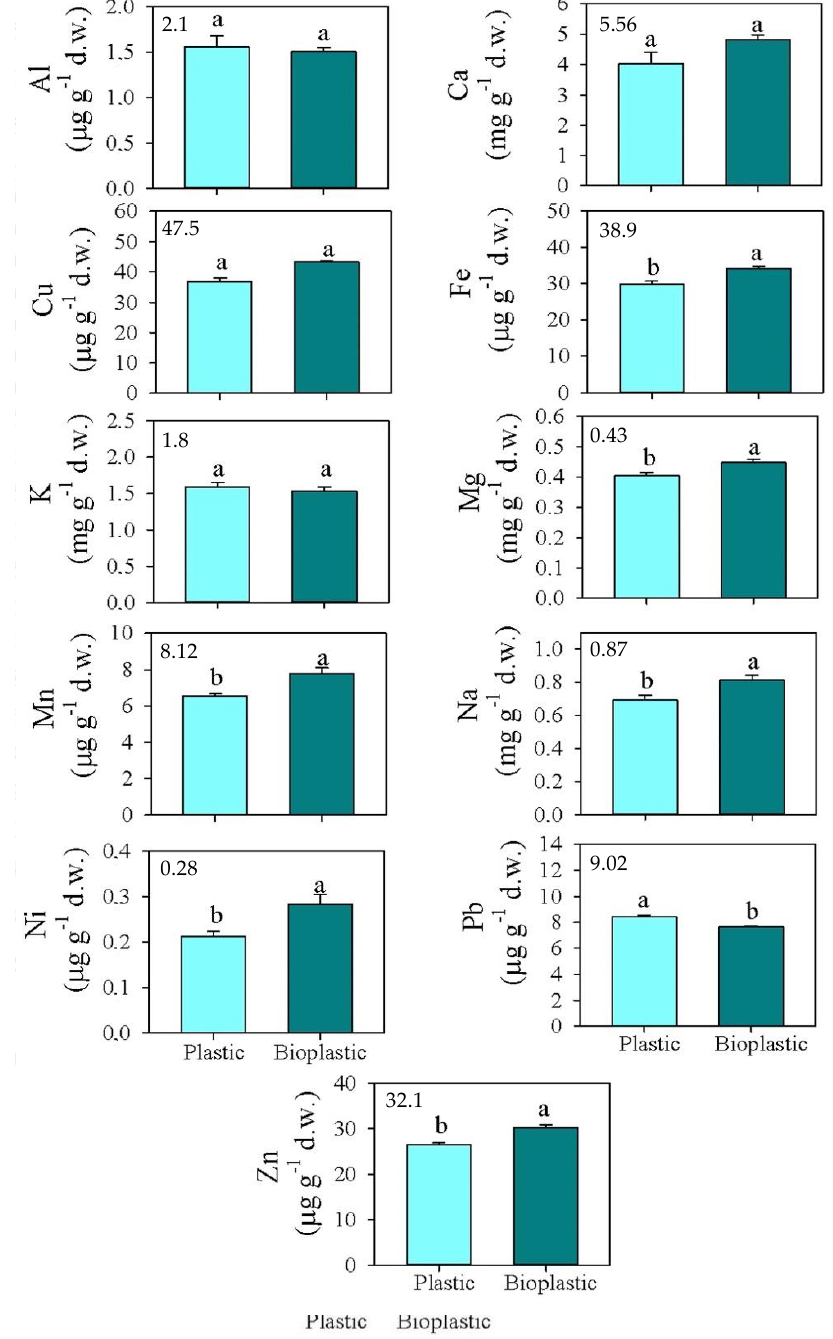
Figure 2. Mean values (± s.e.) of available Al, Cu, Fe, Mn, Pb, and Zn (expressed as μg g −1 d.w.), and Ca, K, Mg, and Na (expressed as mg g −1 d.w.) concentrations measured in soils at T0 ( top left ) and after six months of exposure to plastic (light blue) and bioplastic (dark blue). Different small letters indicate statistically significant differences between soils covered by plastic and bioplastic, respectively (one-way ANOVA; p <